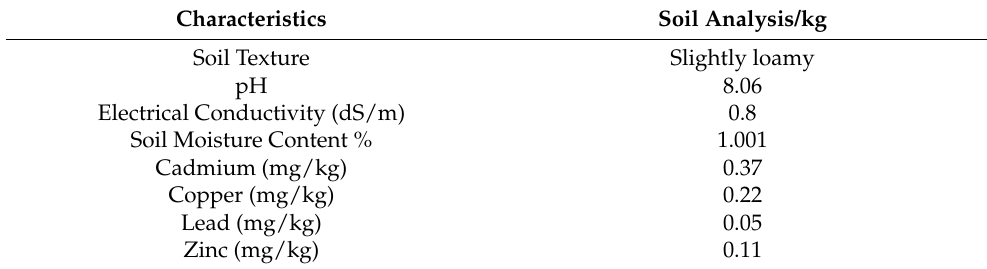
Table 1. Soil physiochemical attributes.